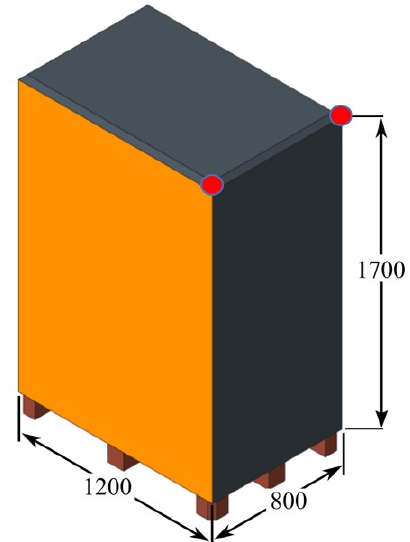
Figure 1. The design of FURBOT freight